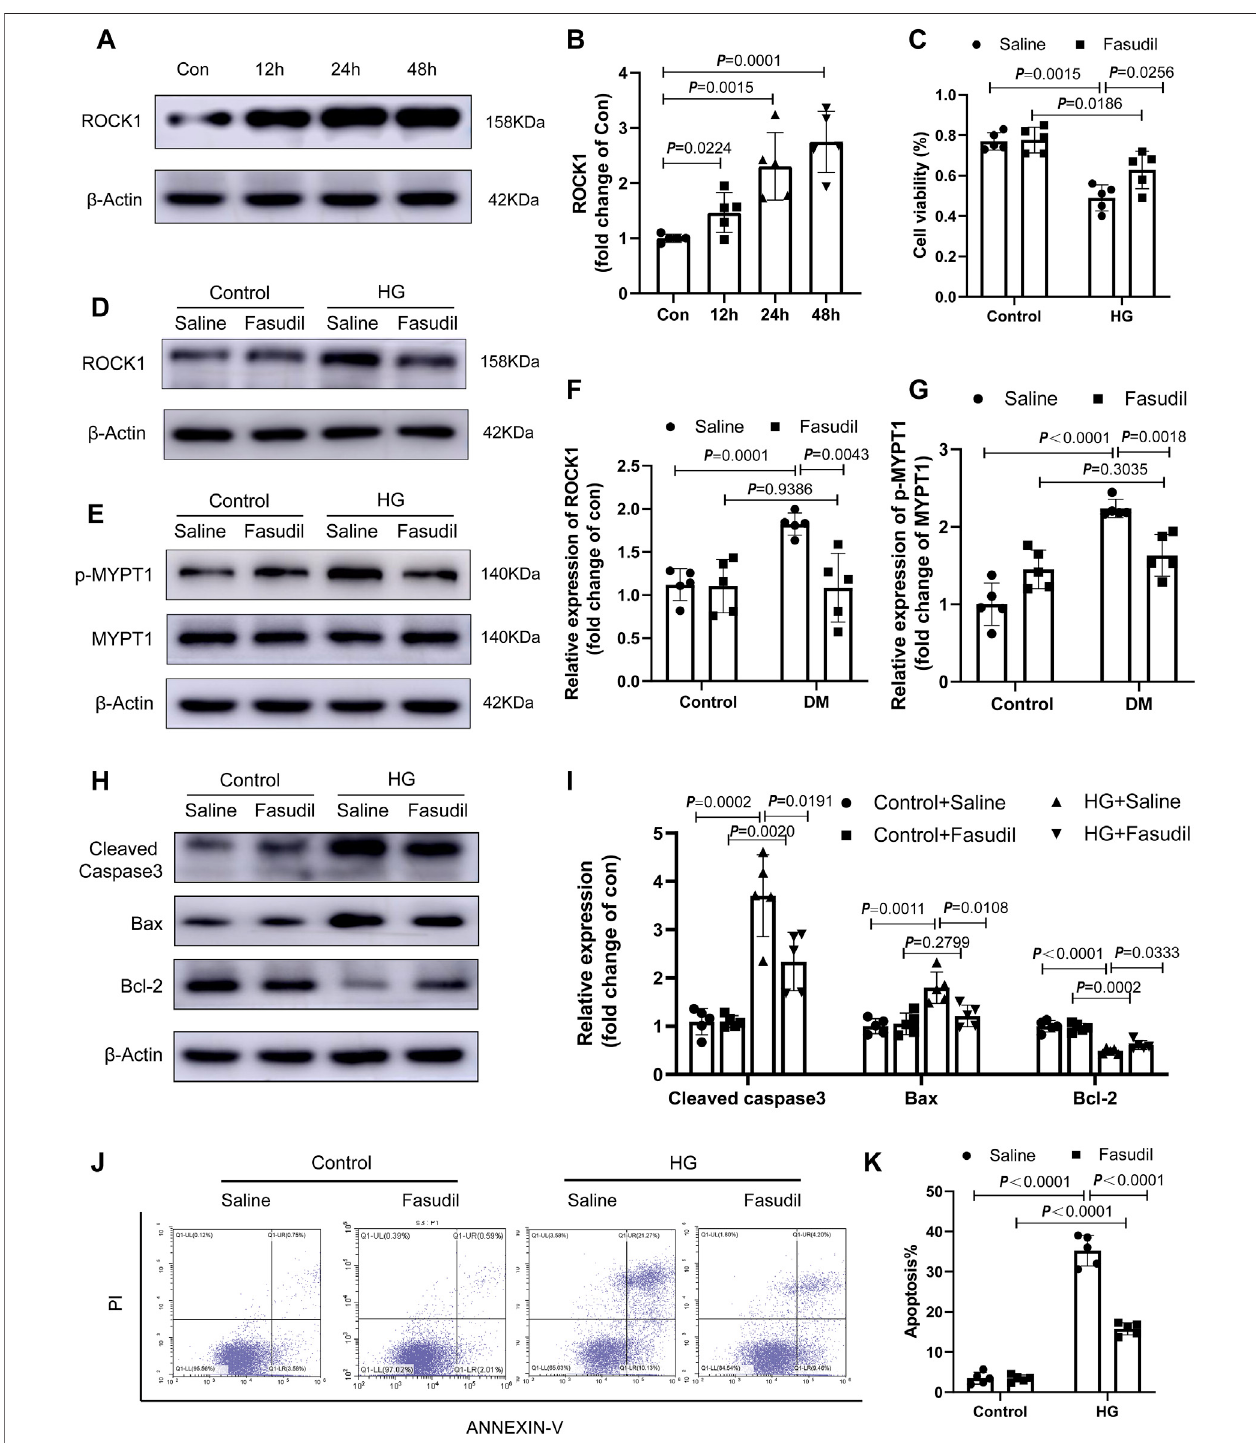
FIGURE 5 | Fasudil ameliorated cardiomyocyte apoptosis induced by hyperglycemia and hyperinsulinemia in vitro (A,B) Immunoblotting and the relative quantitative assessment of ROCK1 levels in NMCMs treated high glucose (33 mM) and insulin (10 nmol/L) for different times (12 – 48 h) (n = 5) (C) The effect of Fasudil in responsetoHGontheproliferationindexofcardiomyocytesusingtheCCK8assay(n=5) (D – G) ImmunoblottingandtherelativequantitativeassessmentofROCK1and p-MYPT1 in NMCMs treated with HG or HG + Fasudil (100 μ M) treatment for 48 h (n = 5) (H,I) Representative immunoblots and quanti fi cation of Cleaved Caspase3,BaxandBcl-2inNMCMstreatedwithHGorHG+Fasudil(100 μ M)treatmentfor48 h(n=5) (J,K) Apoptosisdetection andquantitative analysisviaAnnexin V/PI staining of cardiomyocytes in HG conditions or Fasudil treatment for 48 h (n = 5). p -values were adjusted for comparisons of multiple means.